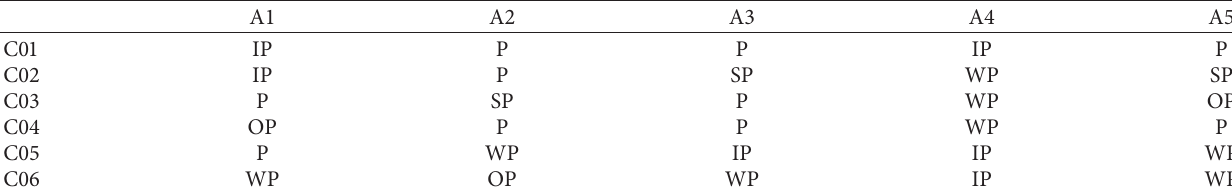
Table 8: Linguistic terms of the decision-maker’s viewpoint in social criteria.